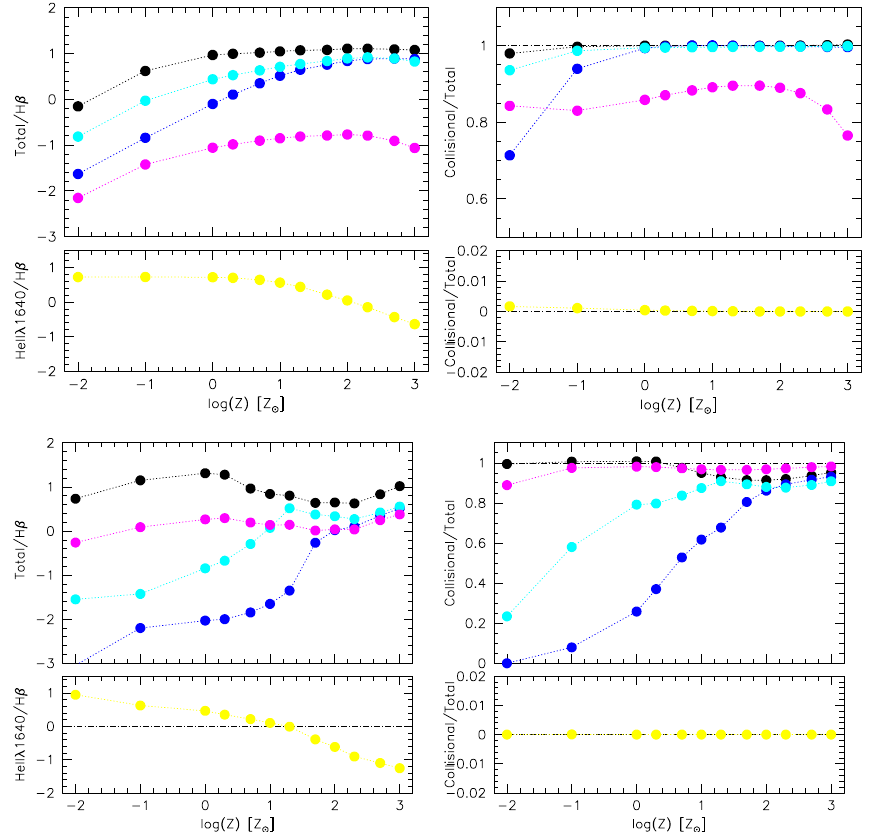
• Figure 5. Left panels: the decimal logarithm of the intensity of C IV relative to H β (black circles, ), • • • Al III (blue, ), Si IV (cyan, ), and N V (magenta, ) as a function of metallicity Z in solar units; the • lower panel shows the same trend for the He II λ 1640 line (yellow, ). Right panels: the dependence of the ratio collisional emission over total line intensity R c for C IV on metallicity, with the same meaning of the symbols. Top panel: low ionization case; bottom: high ionization case.